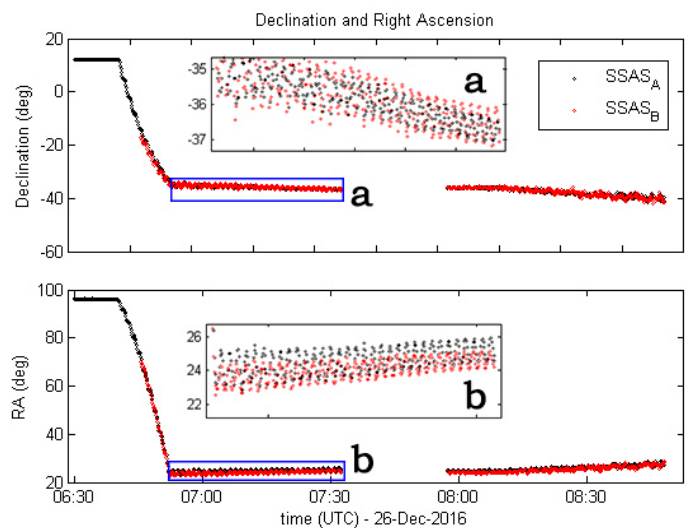
Figure 5. Coarse spin-axis estimation about fifteenth perigee pass (26 December 2016—from 6:30 to 9:00 UTC) using GAS and SSAS measurements. Subfigures a and b zoom to the shown parts.